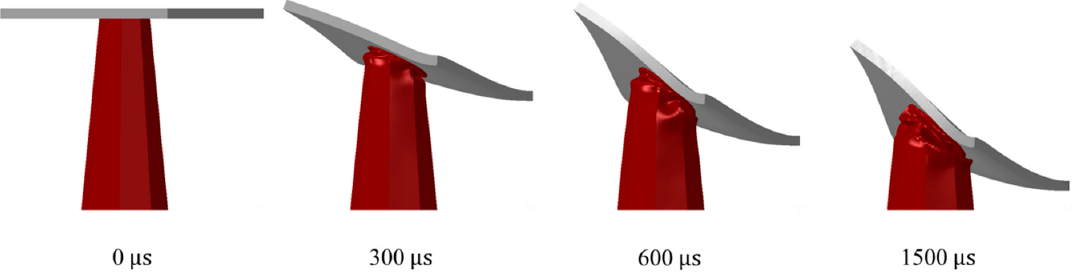
Figure 12. The four modes of deformation for tubes of CR = 1, θ = 5° and R = 3 and different T and t.